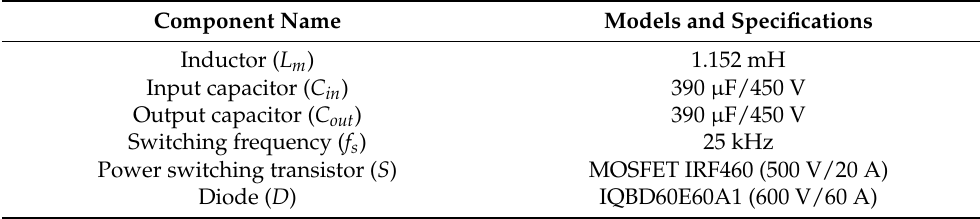
Table 2. Parameter settings of components of the DC/DC boost converter [17].